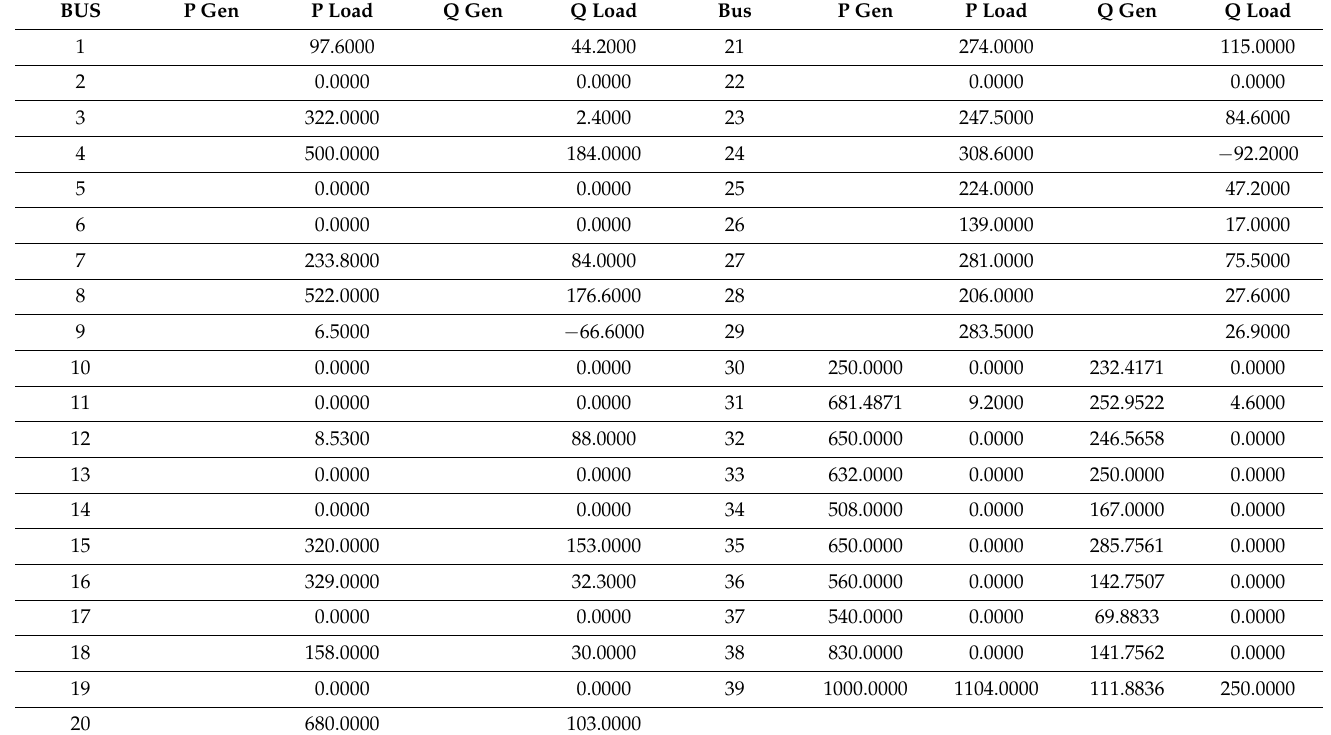
Table A2. Test System